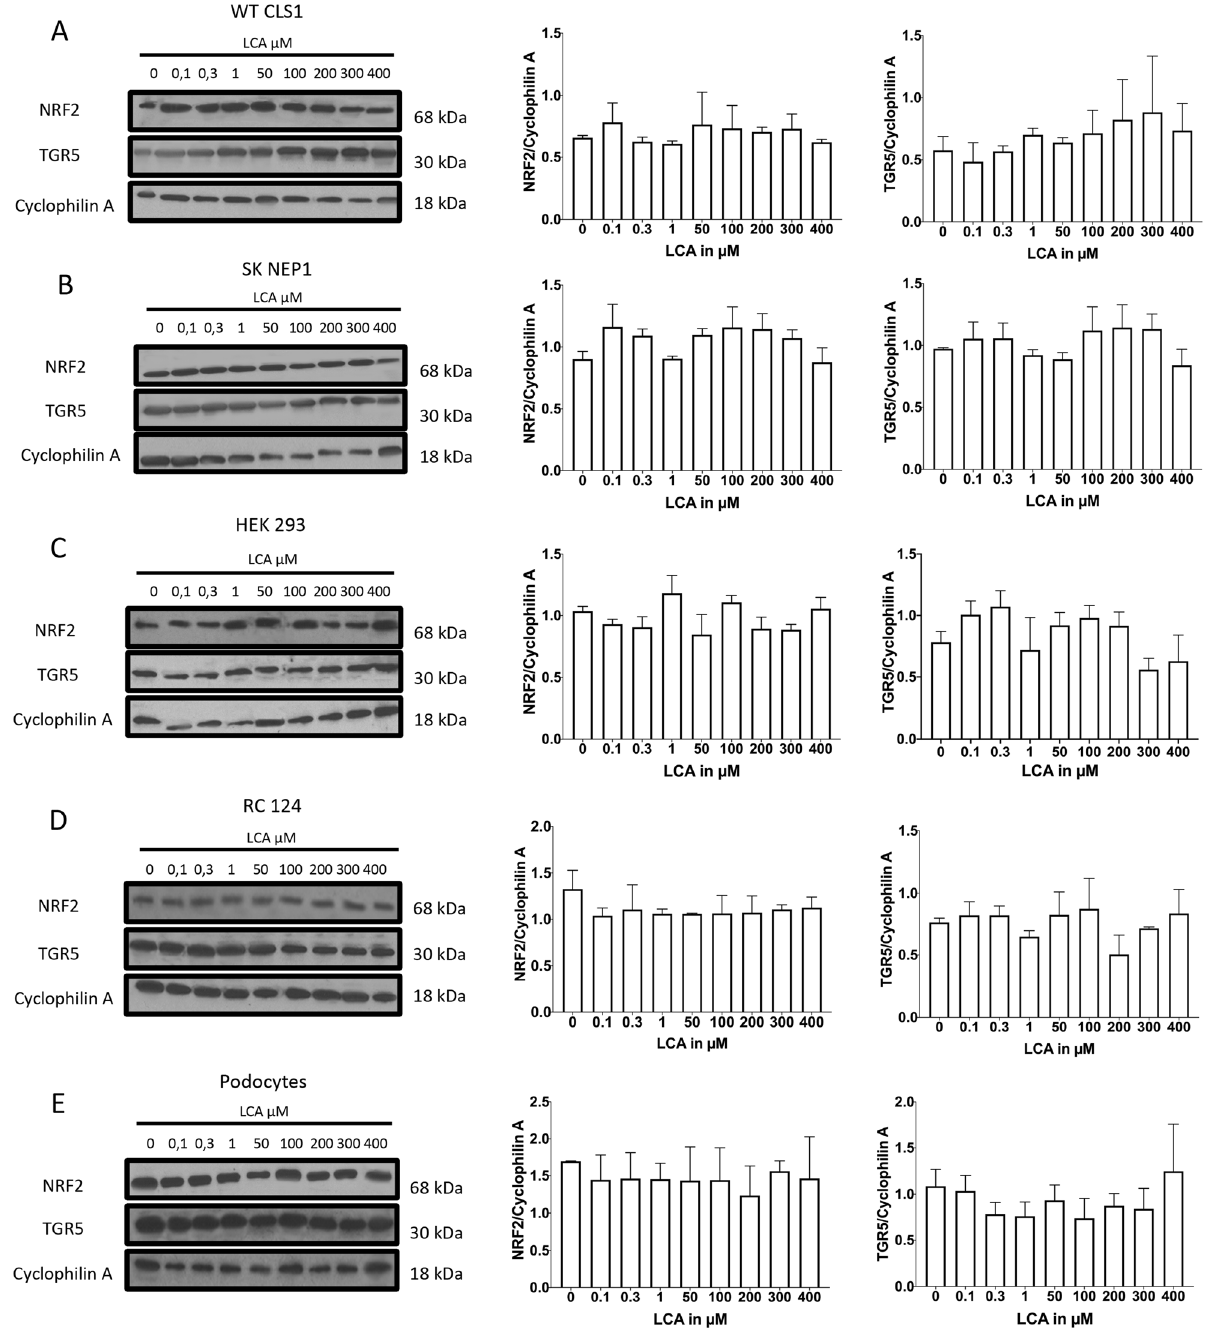
Figure 4. Expression of NRF2 and TGR5. All cell-lines were treated as described in “Methods”. Cell lysates were subjected to immunoblotting with indicated antibodies. Cyclophilin-A served as loading control. Qantification of NRF2 or TGR5 was performed by densitometry. Data were analyzed using ImageStudioLite Version 5.2.5. and ImageJ. Data are presented as mean ± SD of values from three independent experiments. Significance level was set as p < 0.05 (*< 0.05; **< 0.005; ***< 0.0005; ****< Cell toxicity due to caspase 3 and 7 activation. The activation of caspase 3 and 7 as modulatory pro- teins of apoptosis was detected using the Caspase-Glo 3/7 Assay. Treatment with LCA showed a time and dose dependent increasing level of caspase activation (Fig. 5). When treated for 4 h, only cultured human Podocytes show an increasing level of caspase activity that does not correlate with the corresponding assays. When treated for longer, all cell-lines except HEK 293 show an increasing level of caspase activation with time and dosage.